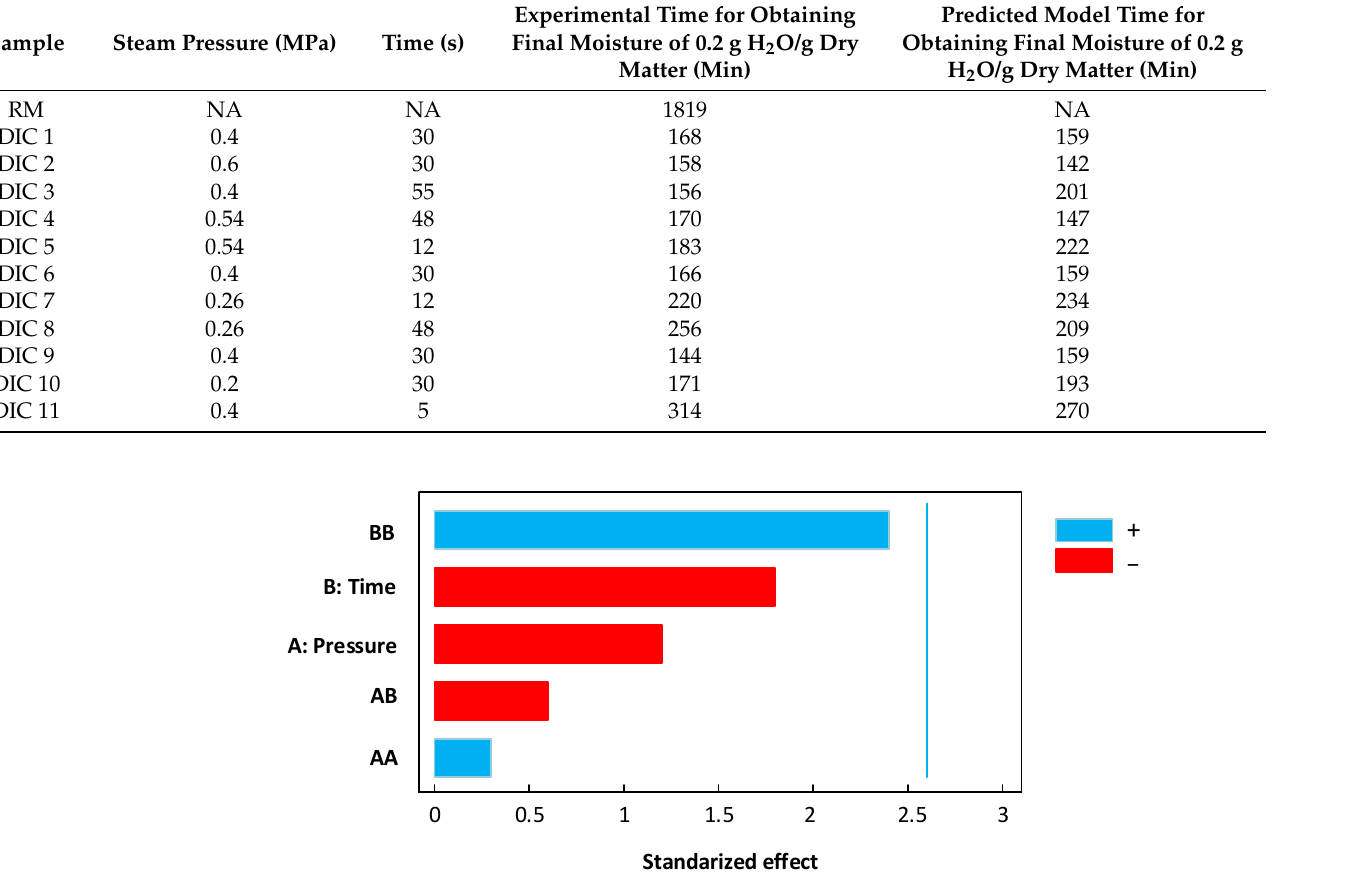
Figure 9. Pareto chart: Effect of DIC treatment on the time for obtaining a final moisture content of 20% d.b.